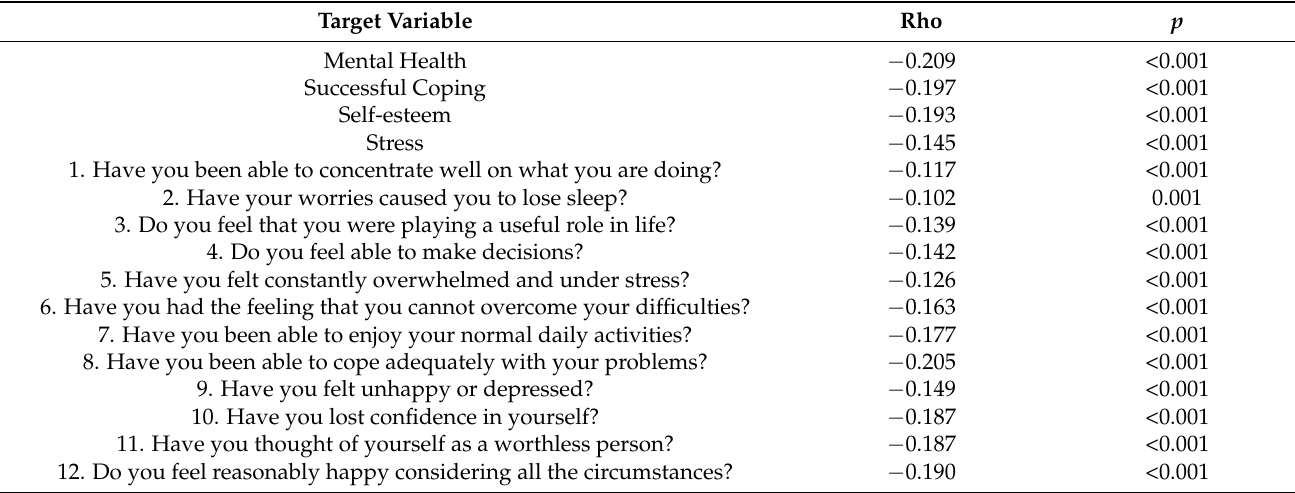
Figure 1. Negative SPH prevalence according to the Physical Activity Level (PAL).